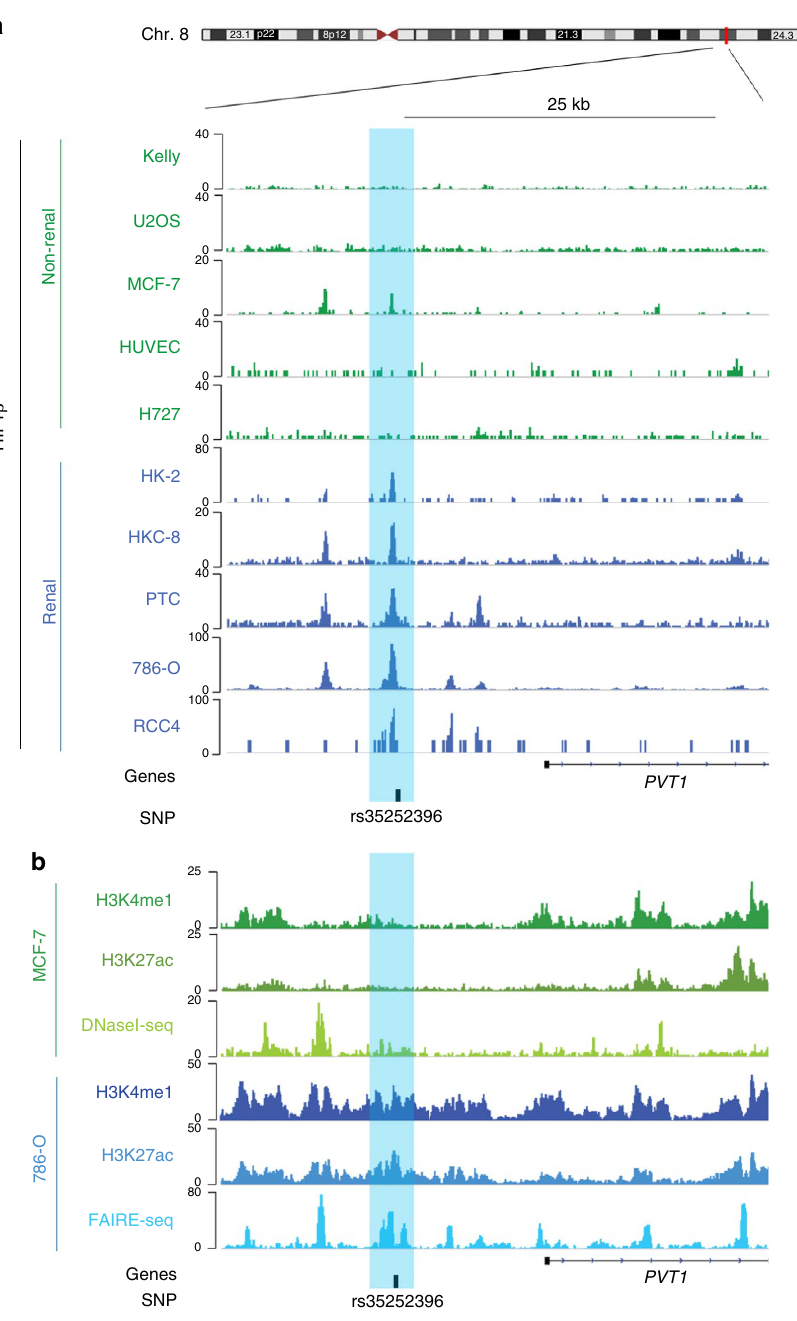
Figure 2 | HIF-dependent MYC and PVT1 induction in ccRCC. ( a ) HIF-1 b ChIP-seq signals at the 8q24.21 renal cancer susceptibility locus in non-renal cells (green) or renal tubule-derived cells (HK-2, HKC-8: immortalized tubular cells, PTC: primary tubular cells, ccRCC: 786-O and RCC4, blue). In non- ccRCC cells, HIF was stabilized by hypoxia or DMOG for 16h. rs35252396 is located close to the HIF peak (highlighted in light blue) B 14kb upstream of the transcriptional start site of PVT1. ( b ) ChIP-seq (H3K4me1 and H3K27ac), DNaseI-seq and FAIRE-seq signals in MCF-7 breast cancer and 786-O renal cell carcinoma cells reveal features of active and open chromatin at the 8q24.21 SNP-associated HIF-binding site (highlighted in light blue) in 786-O cells, but not MCF-7